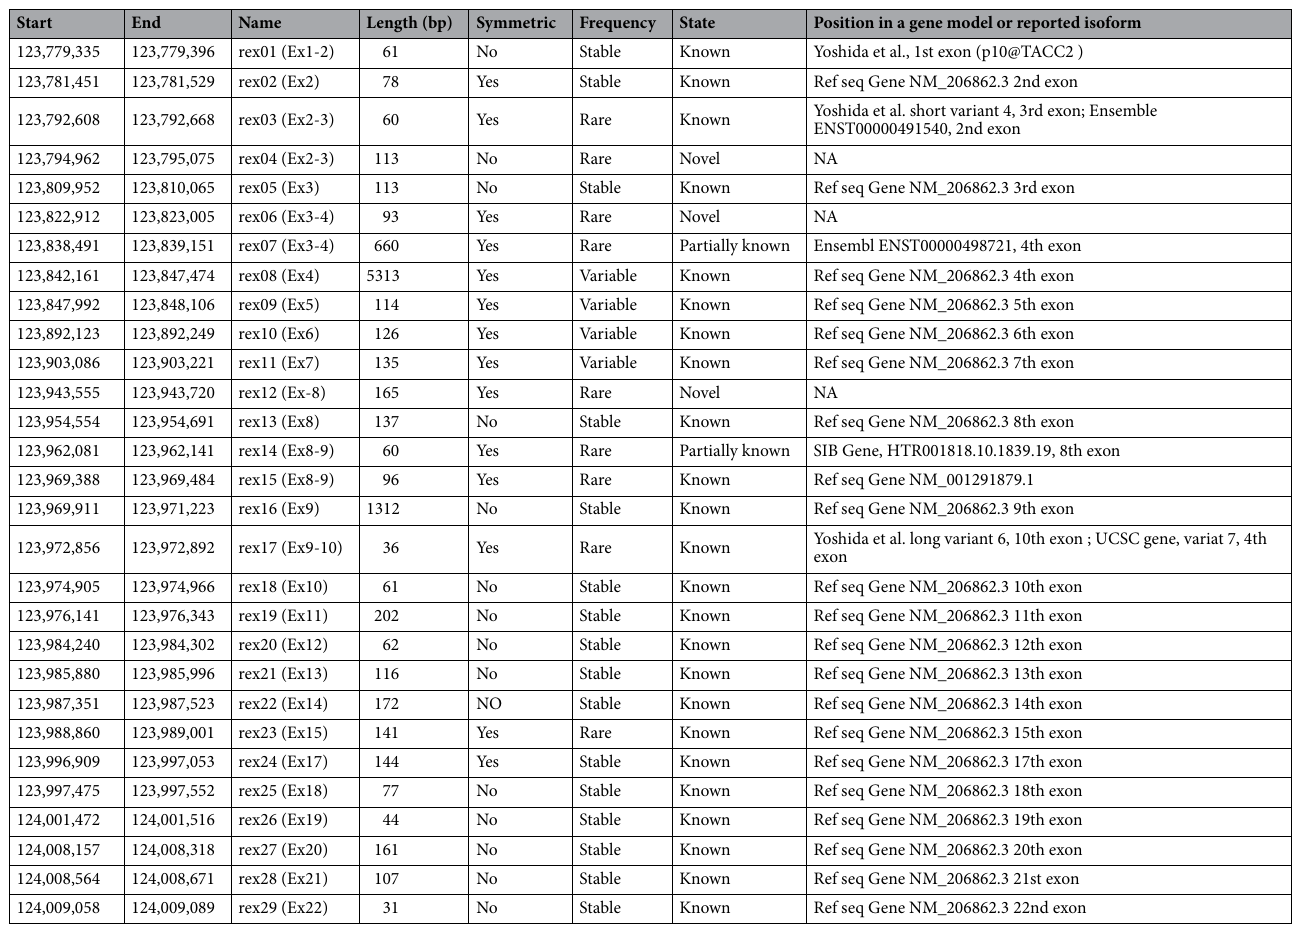
Table 1. Representative exon boundaries identified by long-read sequencing. Genomic coordinates (start, end) on chromosome 10 are based on GRCh37 human genome assembly (hg19). Exon names are prefixed by “rex” (e.g., rex01), with exon order in a previous study 6 indicated in parentheses (e.g., Ex2 indicates the second exon, and Ex2-3 indicates an intron between the second and third exons). When the number of nucleotides in an exon is a multiple of 3, it is referred as symmetric and could be skipped without a change in the reading